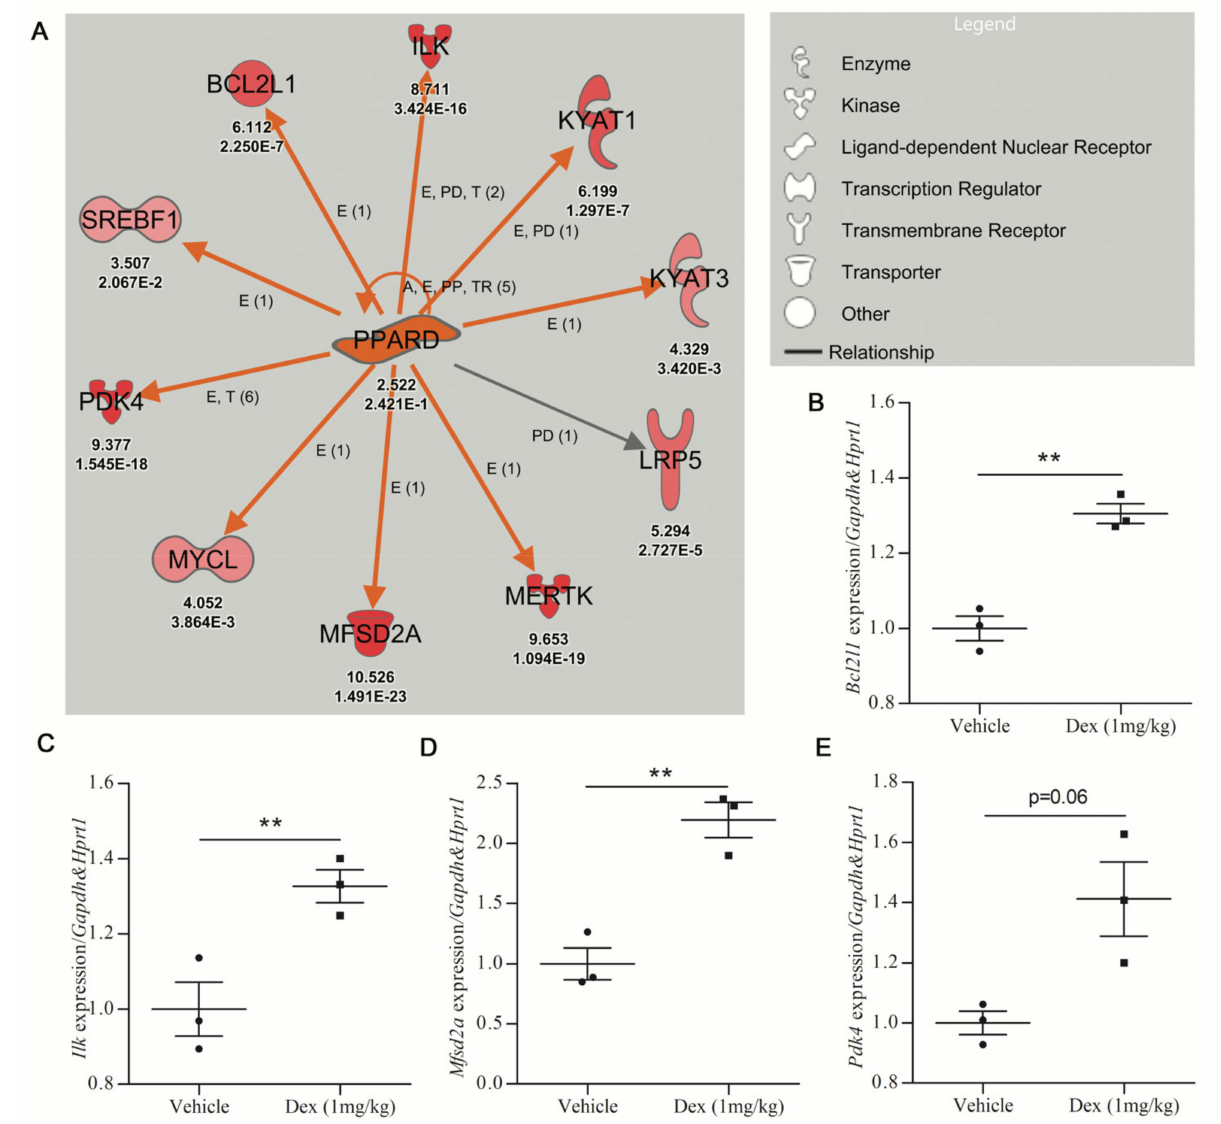
Figure 3. Validation efficiency for upregulated gene expression prioritized by IPA analysis. ( A ) The PPARD upstream regulator identified by URA analysis is upregulated in dexamethasone-treated mouse cerebrocortical cultures (Care4Rare Neuron Screen). Orange arrows signify an activating relationship with downstream genes and red symbols signify upregulated genes with the Neuron Screen Z-score and p -adj appearing directly below each symbol. Only genes for which p -adj < 0.05 are included. ( B–E ) Adult male C57BL6 mice were treated p.o. with vehicle or DEX (1 mg/kg) for 5 days, and qRT-PCR was employed to determine gene expression of 7 of the 10 targets of PPARD ( n = 3). The four genes with the most robust upregulation are shown. ( B ) Bcl-2-like protein 1 ( Bcldl1 ). ( C ) Integrin-linked kinase ( Ilk ). ( D ) Major facilitator superfamily domain containing 2A ( Mfsd2a ). ( E ) Pyruvate dehydrogenase kinase 4 ( Pdk4 ). For all hits, statistical significance was measured by Student’s paired two-tailed t -test (** p <